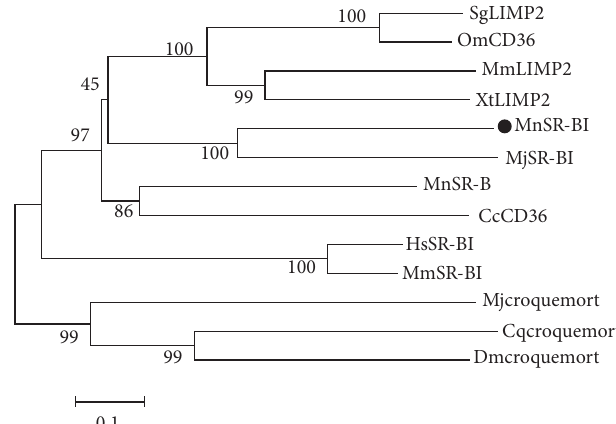
Figure3:PhylogenetictreeinferredfromarthropodPPAFsaminoacidsequences.Speciesnamesareabbreviatedinthetreetorepresent Culex